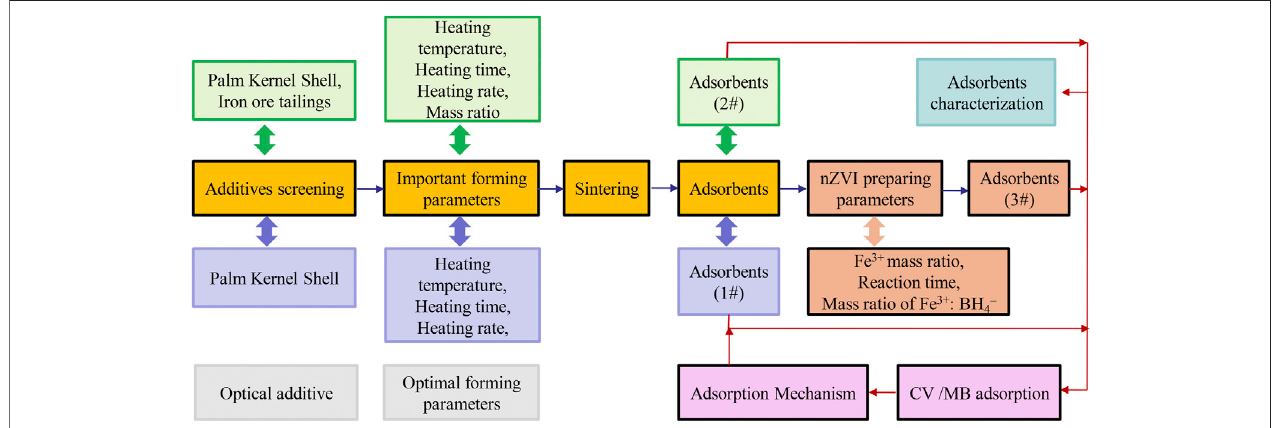
FIGURE 1 | Schematic of the preparation of the adsorbents.